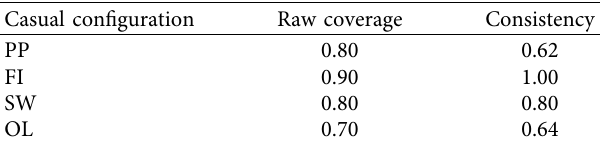
Table 10: Results of coverage and consistency analysis. Table 11: Results of raw coverage and consistency for each